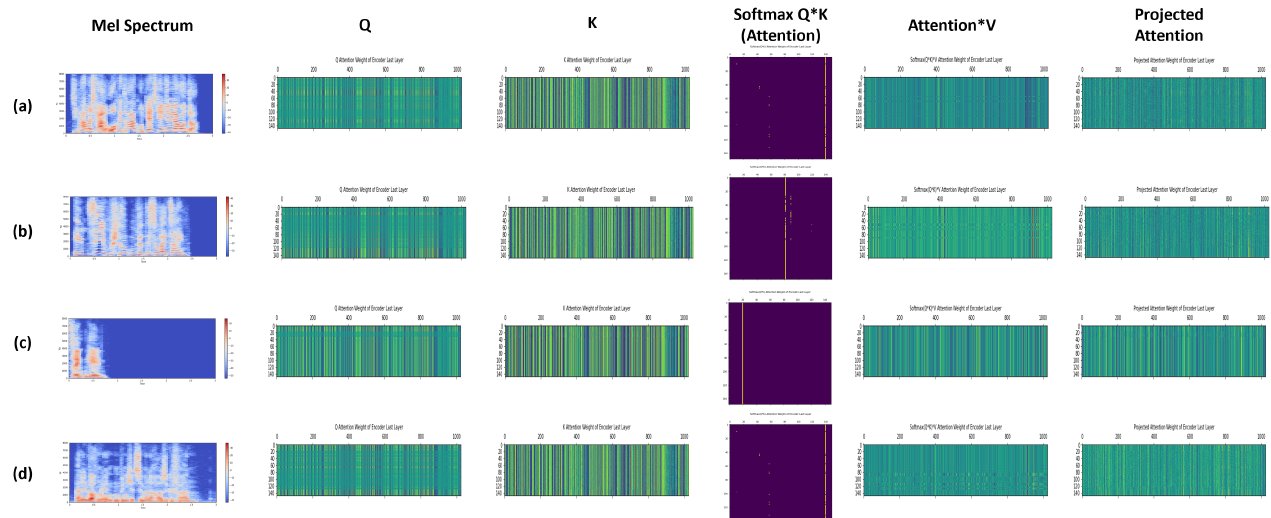
Figure 3. Attention weights of the last layer encoded feature using transfer learning of Wav2Vec2 based on the Emo-DB dataset: ( a ) normal speech chunk, ( b ) chunk containing normal silence, ( c ) chunk containing mostly silence, and ( d ) chunk between speech. Please see the full resolution image in the supplementary material.